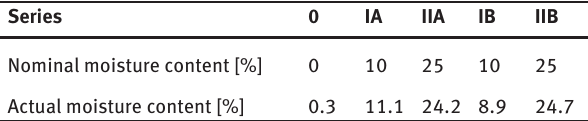
Table 2: Aggregate moisture content check